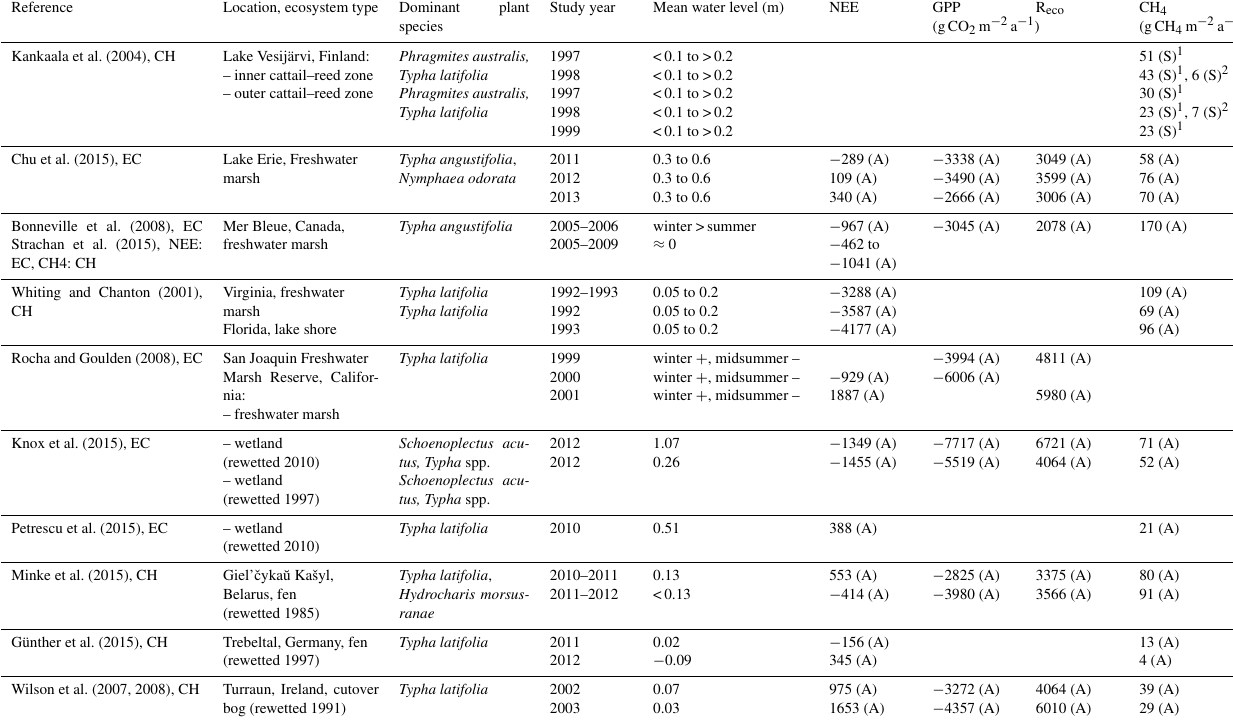
Table 5. Annual (A)/seasonal (S) NEE, GPP, R eco and net CH 4 exchange at Typha sites. Positive water level indicates inundated soil. GHG flux measurement methods are denoted as CH for chambers and EC for eddy